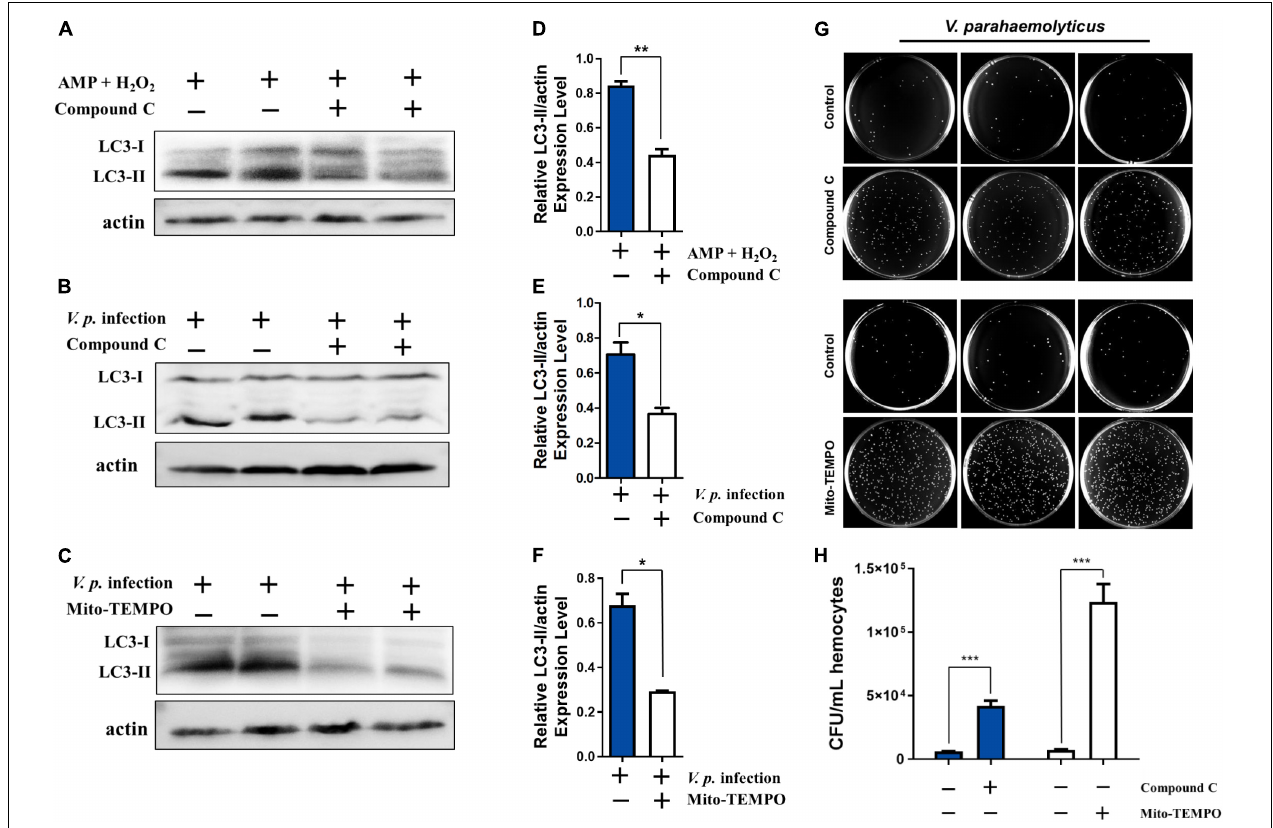
FIGURE 5 | Stimulatory effects on infection induced autophagy are dependent on AMPK pathway and oxidative stress. (A) Western blot analysis showing that autophagy induced by AMP + H 2 O 2 co-treatment declined after treatment with the AMPK inhibitor Compound C. (B,C) Western blot analysis showing that autophagy induced by V.p. infection (for 6 h) was blocked after treatment with Compound C or mitochondria-specific ROS scavenger mito-TEMPO. (D) Densitometric analysis of AMP + H 2 O 2 co-treatment with or without Compound C on the ratio of LC3-II to β -actin by Student’s t test. (E,F) Densitometric analysis of V.p. infection after treatment with Compound C or mito-TEMPO on the ratio of LC3-II to β -actin by Student’s t test, respectively. (G) Representative agar plating results for infection outcomes with treatment of Compound C (up panel) and mito-TEMPO (down panel). C. hongkongensis hemocytes were exposed to Vibrio parahaemolyticus ( V. parahaemolyticus ). (H) Statistical difference in the extent of bacteria clearance the control and Compound C (blue bar) or mito-TEMPO (white bar) groups was determined by Student’s t -test between. Data was presented as mean ± SEM ( n = 3), with significance being determined at * p < 0.05, ** p < 0.01, *** p <